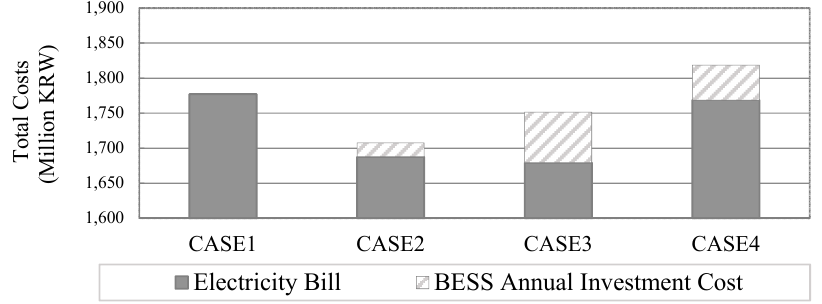
Figure 7. Comparison of total costs by BESS operation strategy.